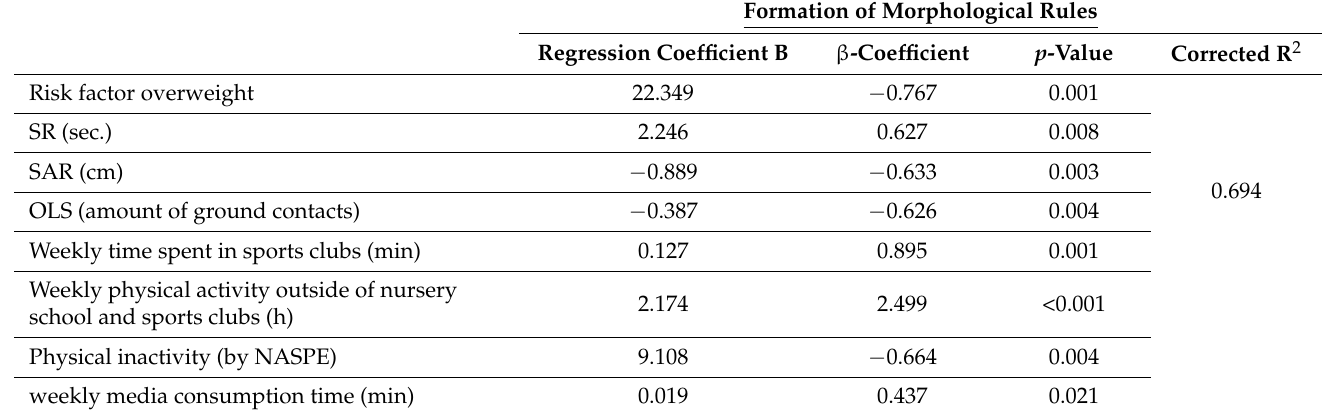
Table 6. Multiple linear regression analysis—End model of the subcategory ‘Formation of morpho- logical